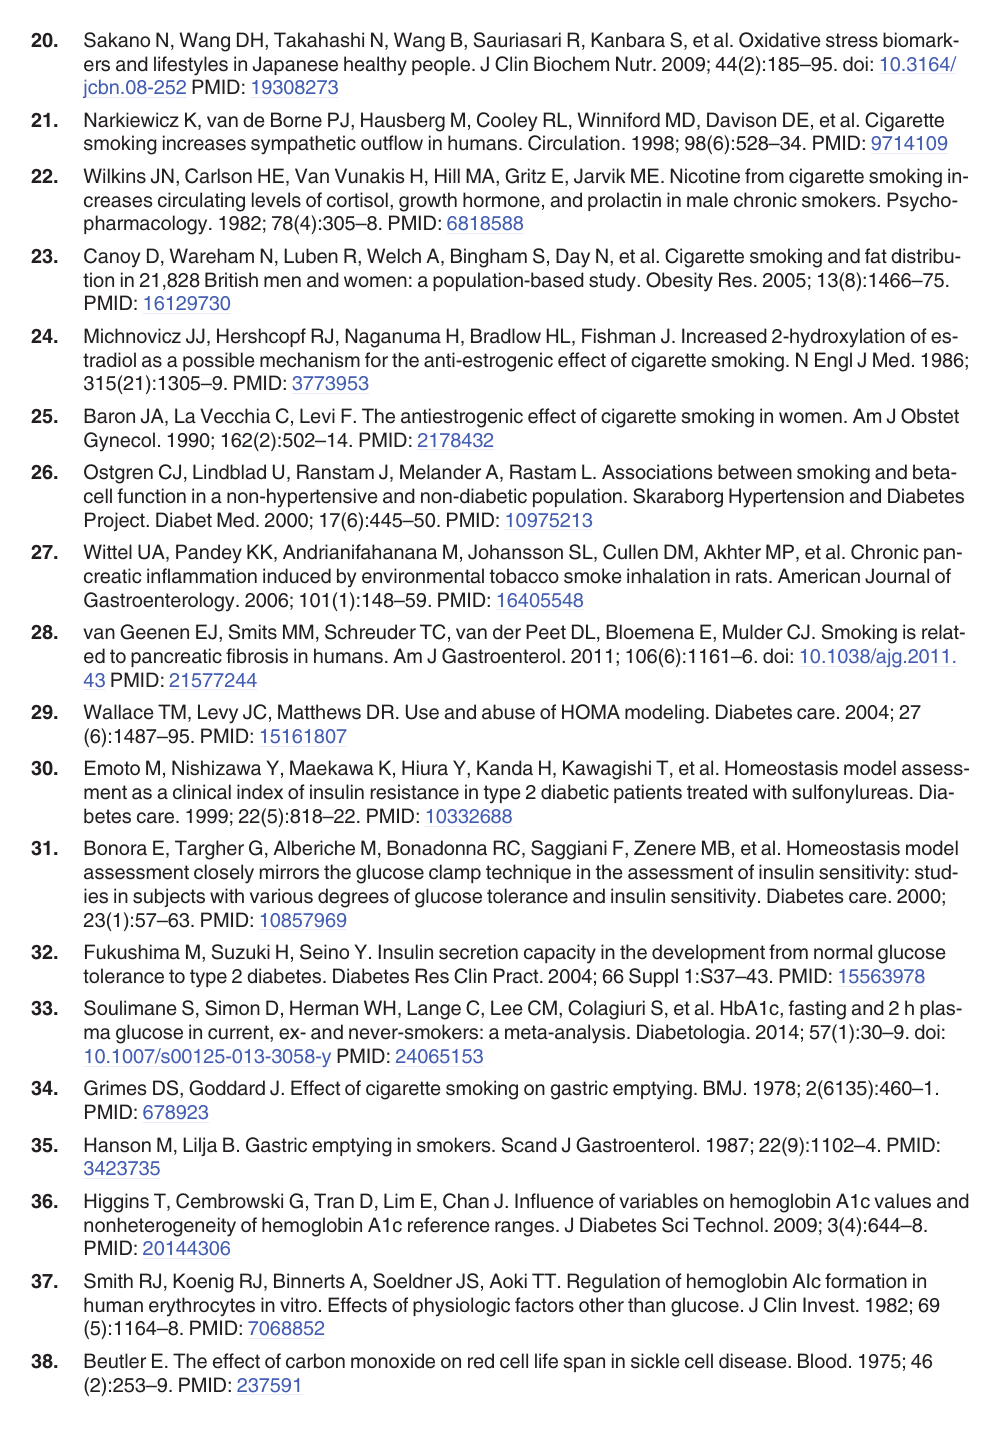
38. Beutler E. The effect of carbon monoxide on red cell life span in sickle cell disease. Blood. 1975; 46 (2):253 – 9. PMID: 237591